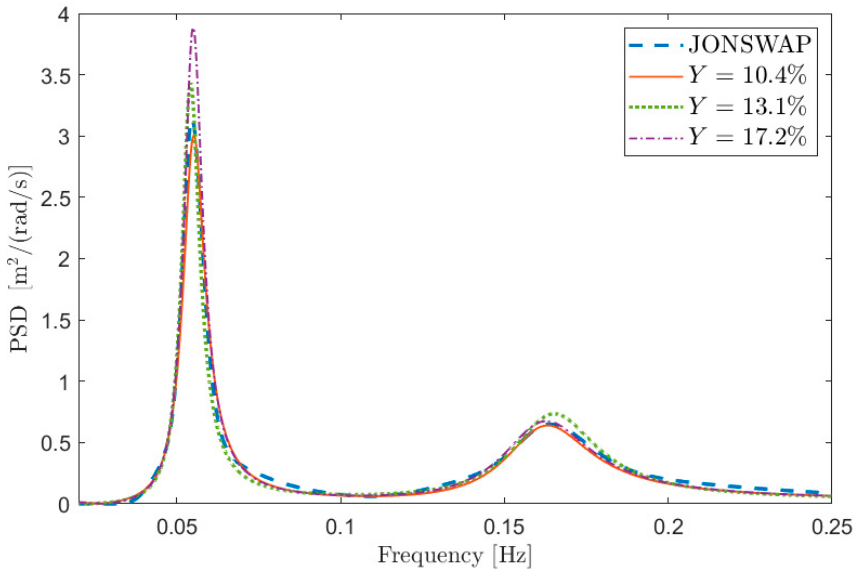
Figure 13. Reconstructed PSD and the corresponding PSD generated with the procedure given in Section 5 (sea state 3 in Table 1) for different 𝑌 values.